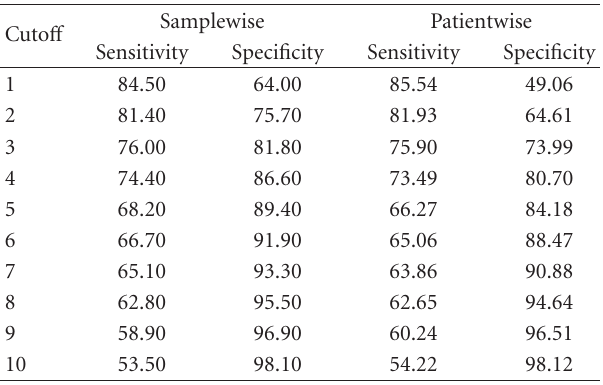
Table 2: Sample-wise and patient-wise sensitivity and specificity at rat agreements cuto ff s